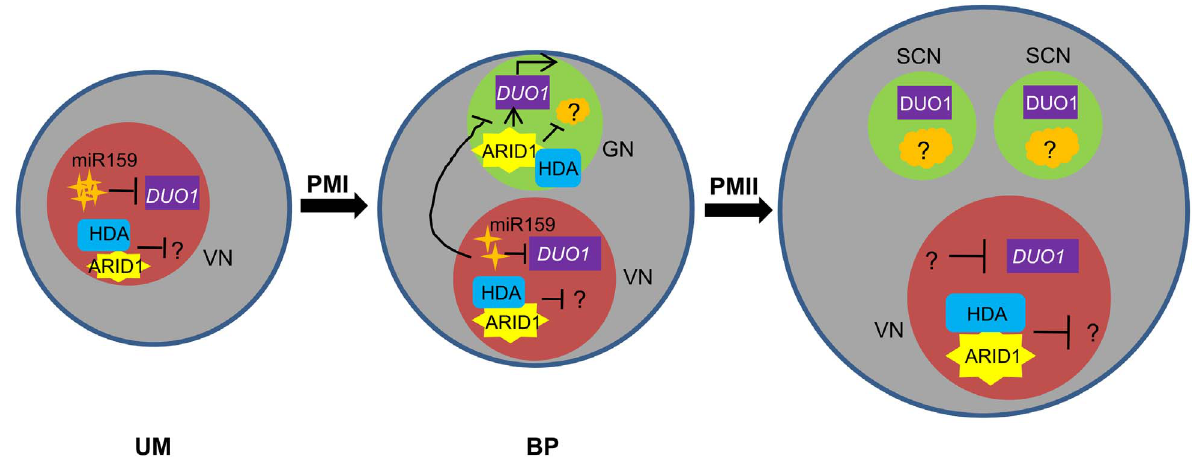
Figure 7. Model for ARID1 function during sperm cell formation in Arabidopsis . miR159 plays a major role in restricting DUO1 expression in the vegetative cell. As pollen development proceeds, miR159 abundance is gradually decreased and ARID1 expands its expression into the generative cell, possibly by responding to the decreased repressive role of miR159 in bicellular pollen. ARID1 then promotes DUO1 activation by directly binding to the DUO1 promoter, and thereby facilitates the initiation of sperm cell formation. On the other hand, ARID1 might repress expression of unknown negative regulators (orange) of cell cycle progression, by altering the epigenetic status of the generative cell. Once sperm cells are formed, ARID1 gradually decreases until it is eliminated from germline cells, so that DUO1 is steadily present and negative regulators possibly related to germline function start to be active, due to dissociation of ARID1 and histone deacetylase. Thus we hypothesize that the alteration of epigenetic status during sperm cell formation is correlated with a change in the subcellular localization of ARID1, which could facilitate cell cycle progression of the two consecutive mitoses. VN, vegetative nucleus; GN, generative cell; SC, sperm cells.